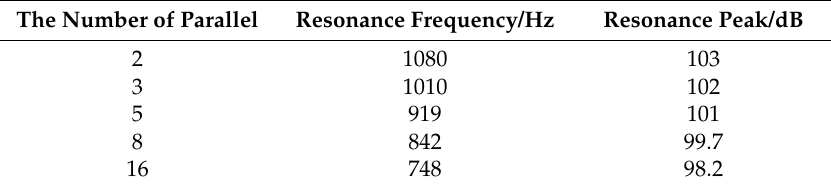
Figure 3. Multiple parallel inverters frequency characteristic curve. Table 2. Resonance peak value of multiple parallel inverters in